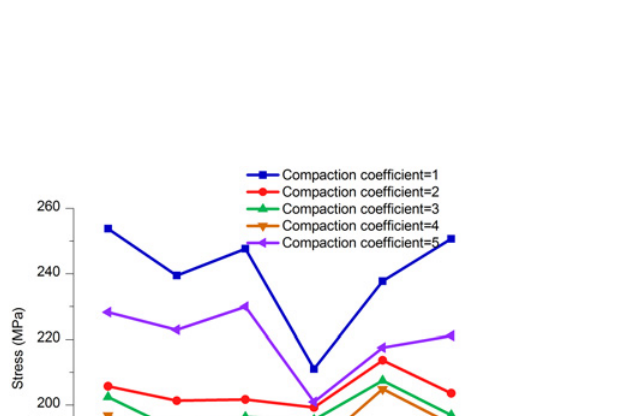
Fig 16. Average stress in pipe models with different Compaction coefficients.